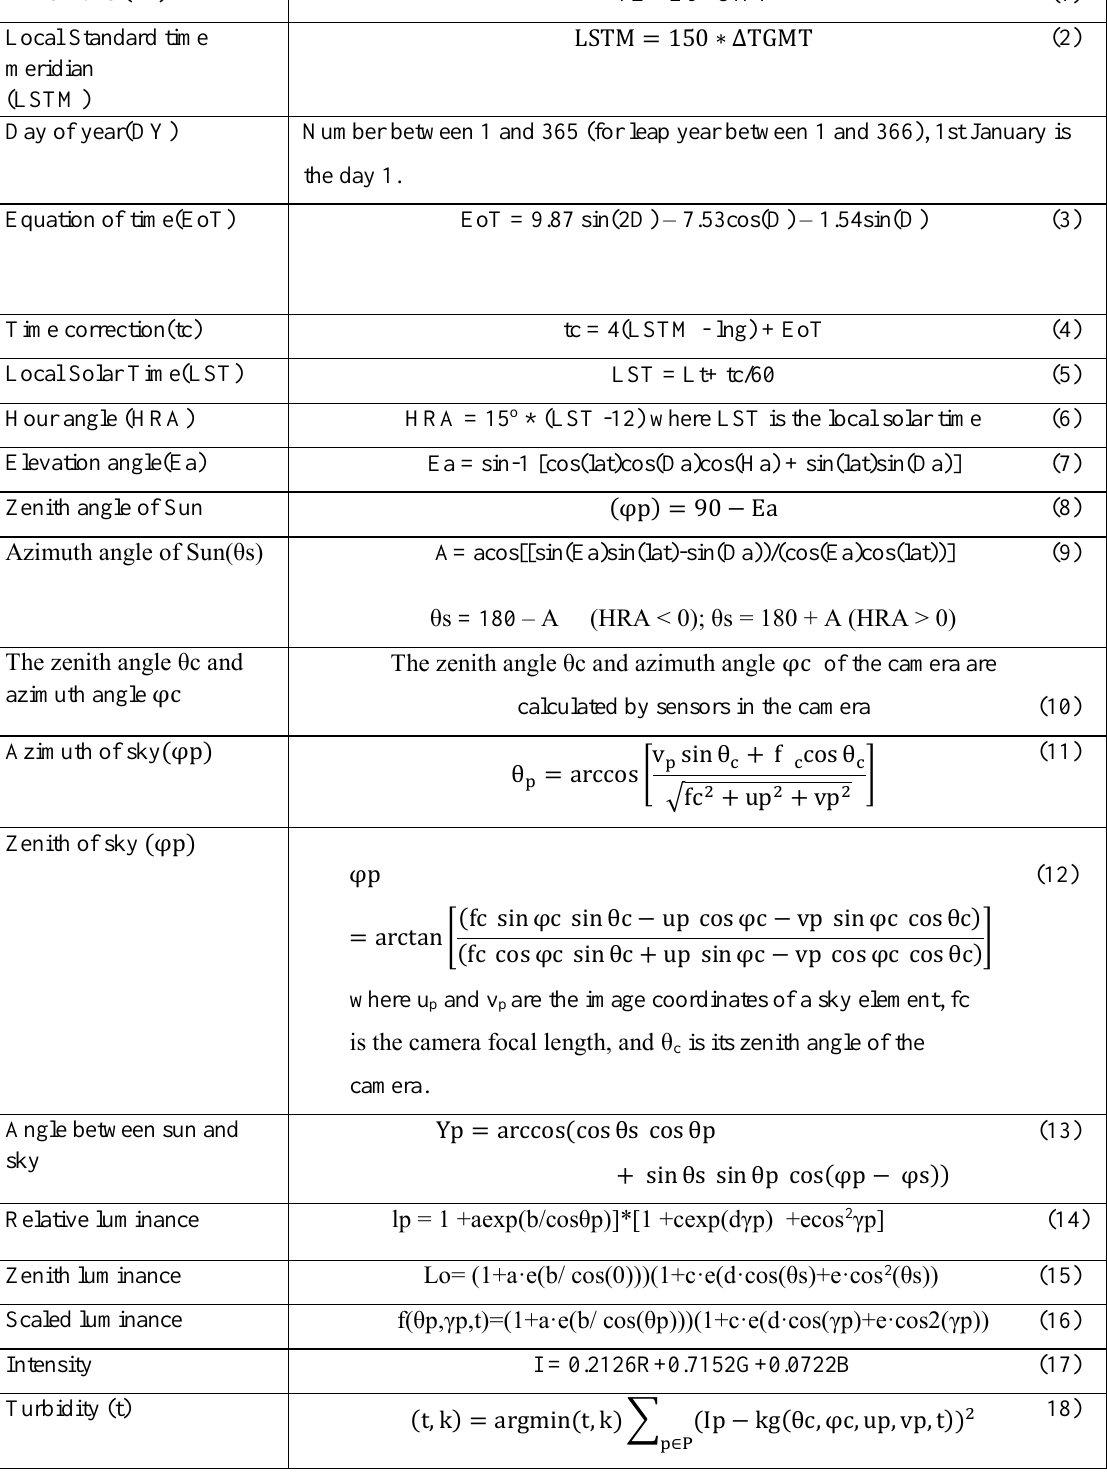
Table 1: summary of Equations